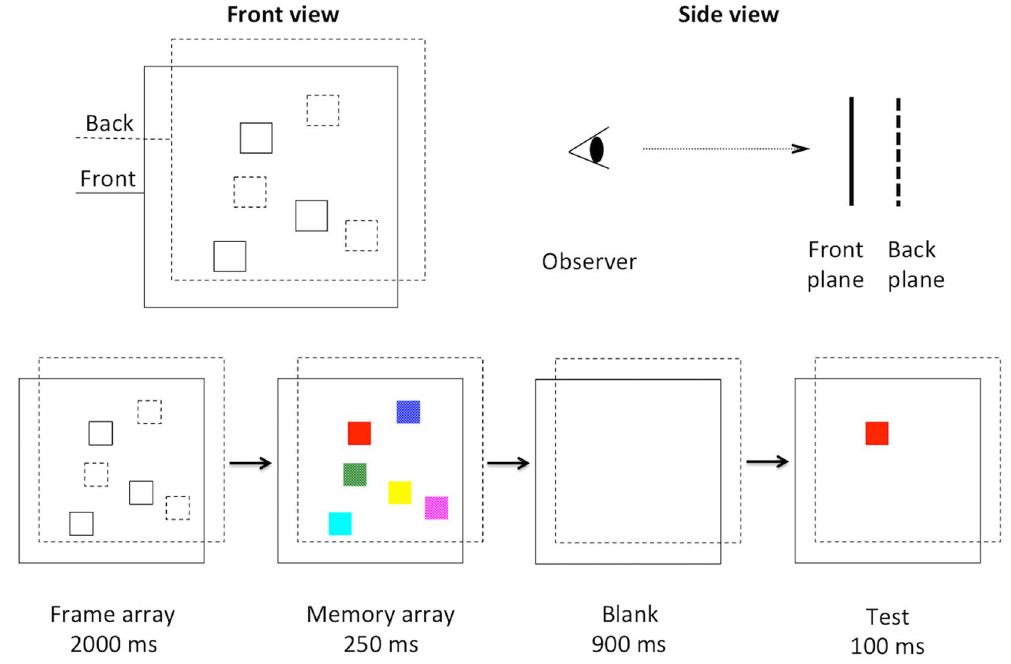
Figure 1. Stimuli and Procedure. Top: the front view and the side view of the frame display. Bottom: task sequences. For demonstration, the frames with solid lines and with dashed lines indicate the front plane and the back plane, respectively. The frame lines were all solid in the formal